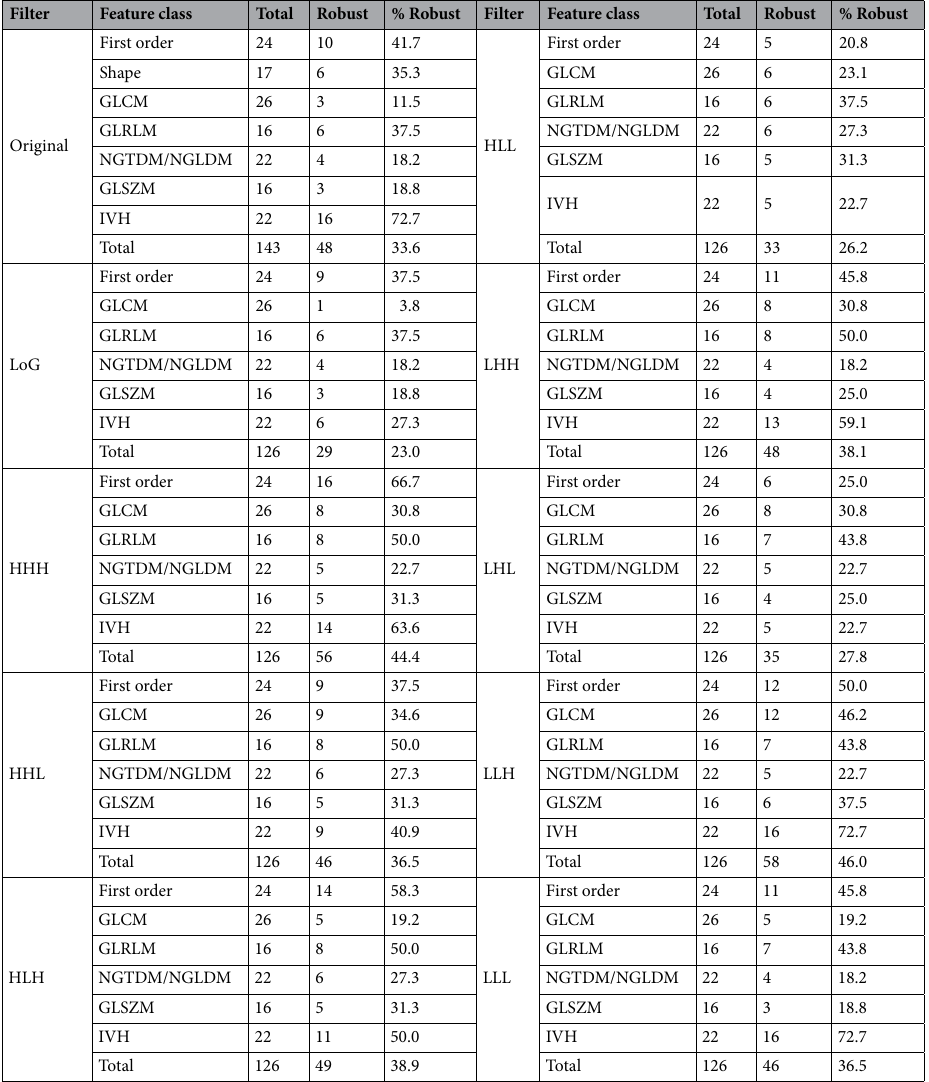
tone difference matrix (NGTDM), and neighboring gray-level dependence matrix (NGLDM), gray-level size zone matrix (GLSZM), and IVH features with respective robust features counts are listed. Feature definitions and calculation provided by Computational Environment for Radiological Research (CERR) 35 , as recommended by the imaging biomarker standardization initiative (IBSI) 36